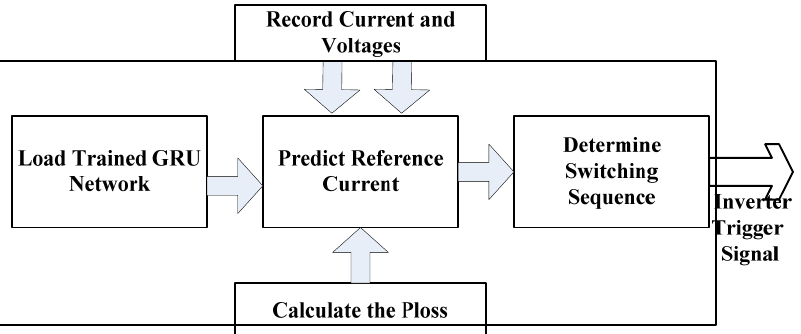
Figure 8. Methodology flowchart for control block for HAPF.